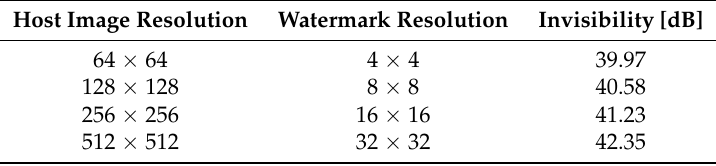
Table 5. Watermark resolution, host image resolution, measured